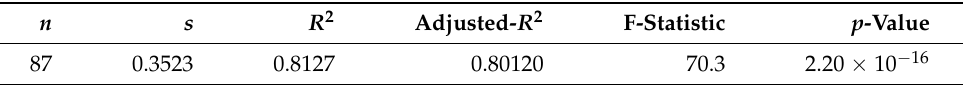
Table 3. All power plants model